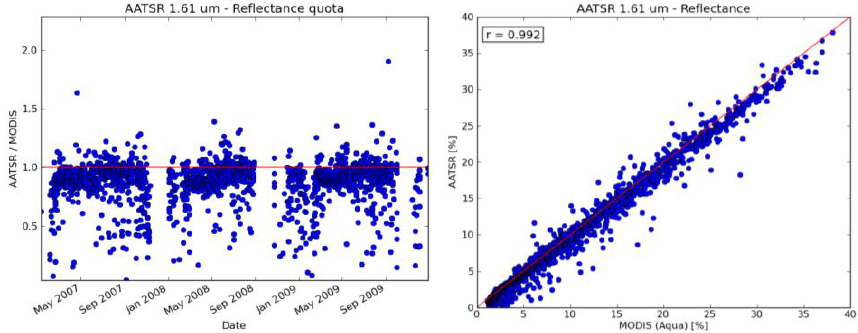
Figure 7. Inter-comparison of normalized reflectance factors against MODIS for the AVHRR-heritage channel at 1.6 µm for AATSR. Left panel show results expressed as reflectance factor quotas over the full time series and the right panel show results expressed as a scatter plot.